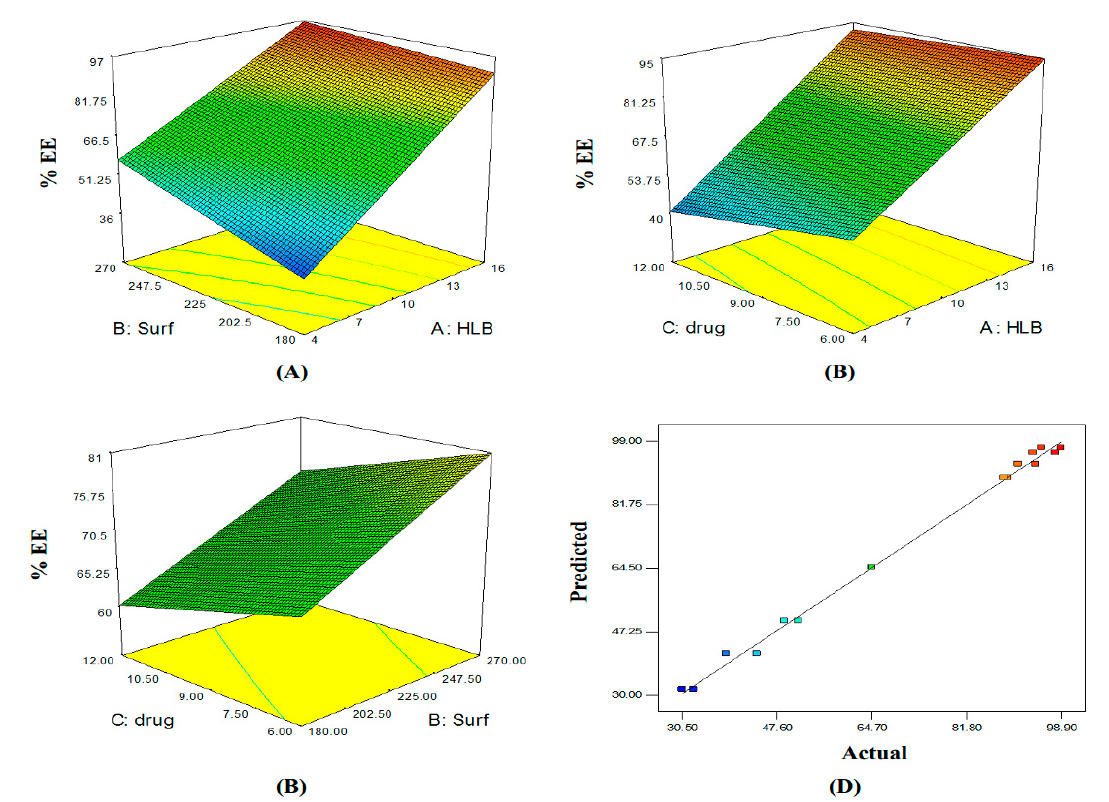
Figure 2. Three-dimensional ( A – C ) plot and linear correlation plot between actual and predicted values ( D ) showing the influence of independent variables on the entrapment efficiency of curcumin proniosomes formulae (Y2).